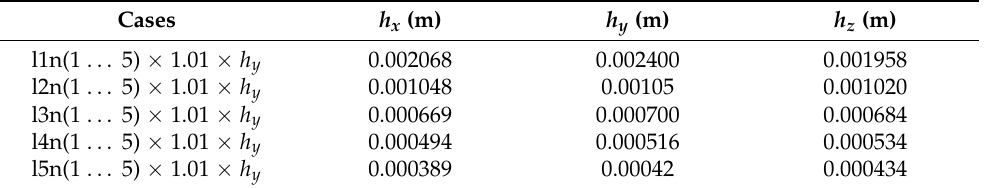
Table 1. Particle (h) and horizon ( δ ) sizes for all instances taken into consideration. Each specimen’s mesh density and five various horizon diameters are taken into account.